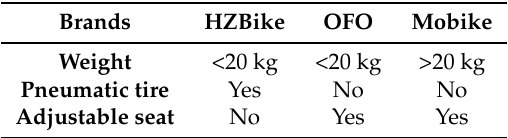
Table 5. Different designs among three brands [41,42].